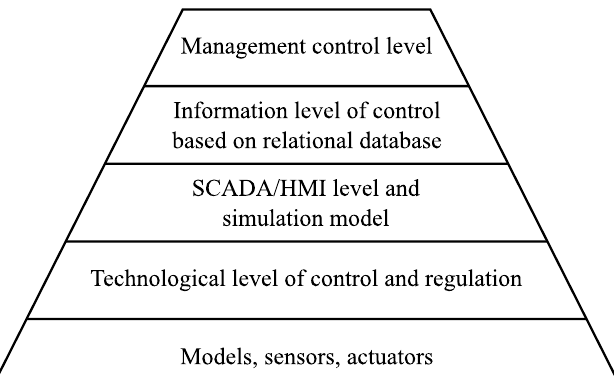
Figure 15. Pyramidal model of the DCS architecture at CMCT&II.